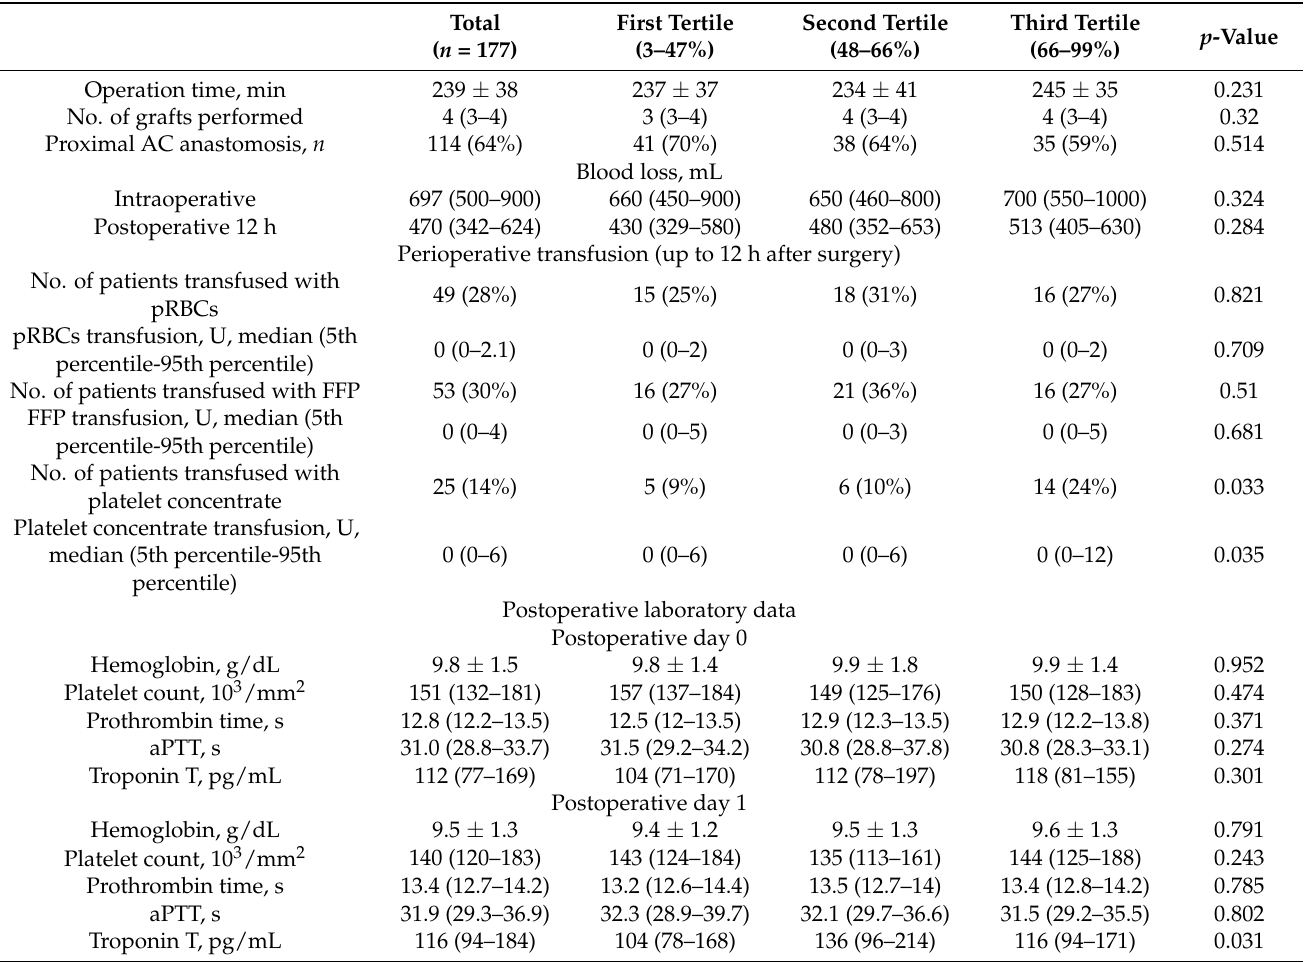
Table 1. Perioperative data in relation to tertile distribution of percentage of platelet inhibitory response to adenosine